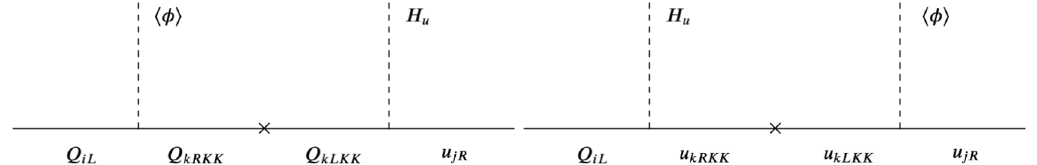
Figure 2 . Diagrams for effective 4d up-type quark Yukawa couplings (see table 2 for notation). Similar diagrams with u → d give the down-type Yukawa couplings. Charged lepton Yukawa couplings arise from similar diagrams involving L i , e j , together with their respective leptonic KK messengers, and H d